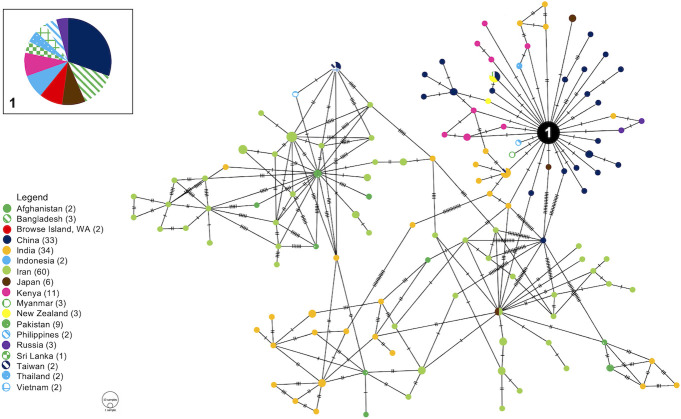
Minimum spanning haplotype network from mitochondrial D-loop data of Mus musculus castaneus.The numbers in the legend are representative of the number of unique haplotypes included in the analysis. The size of each circle indicates the frequencies of the haplotype, and each colour represents the geographical origin of the sequences. The numbered node in the haplotype network corresponds to the numbered inset box. Haplotype diversity resulting from deletions and insertions is not represented in PopART (1.7) networks, therefore all Browse Island samples appear in the same haplotype node.